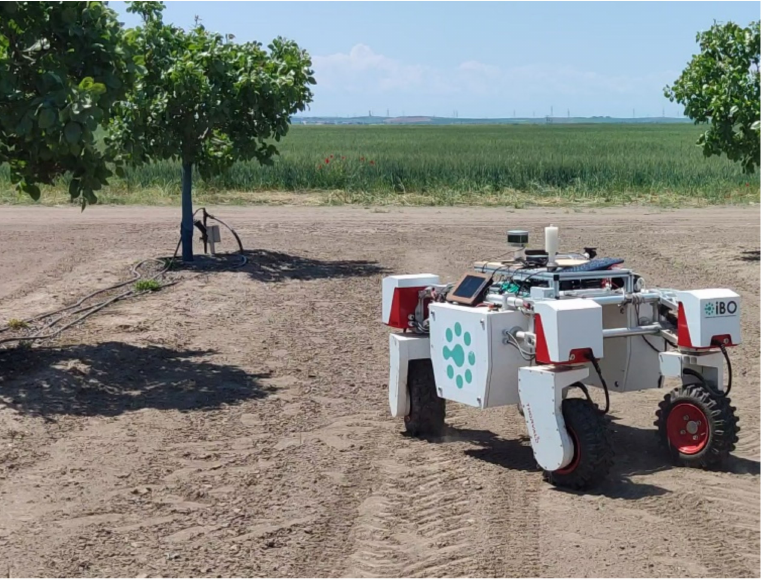
Figure 4. The robotic system used in the present analysis equipped with the required